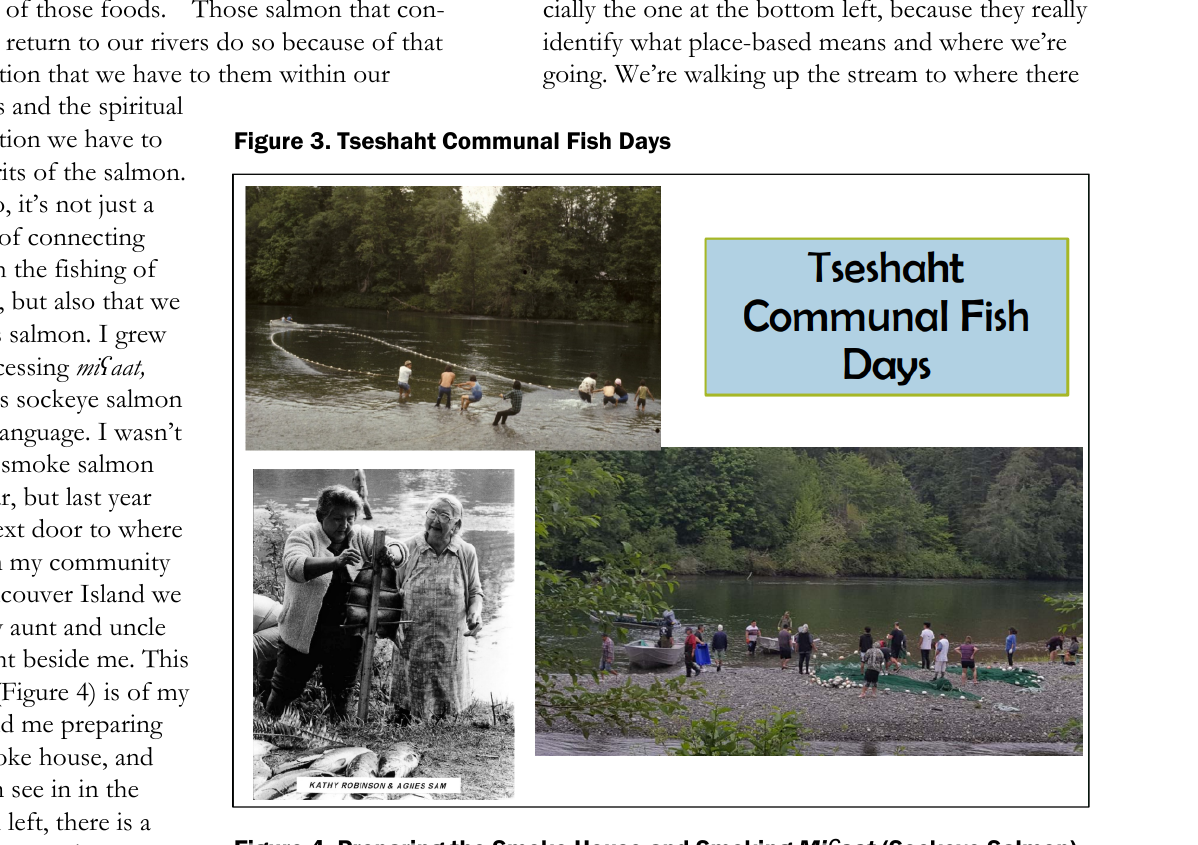
Figure 4. Preparing the Smoke House and Smoking Mi ʕ aat